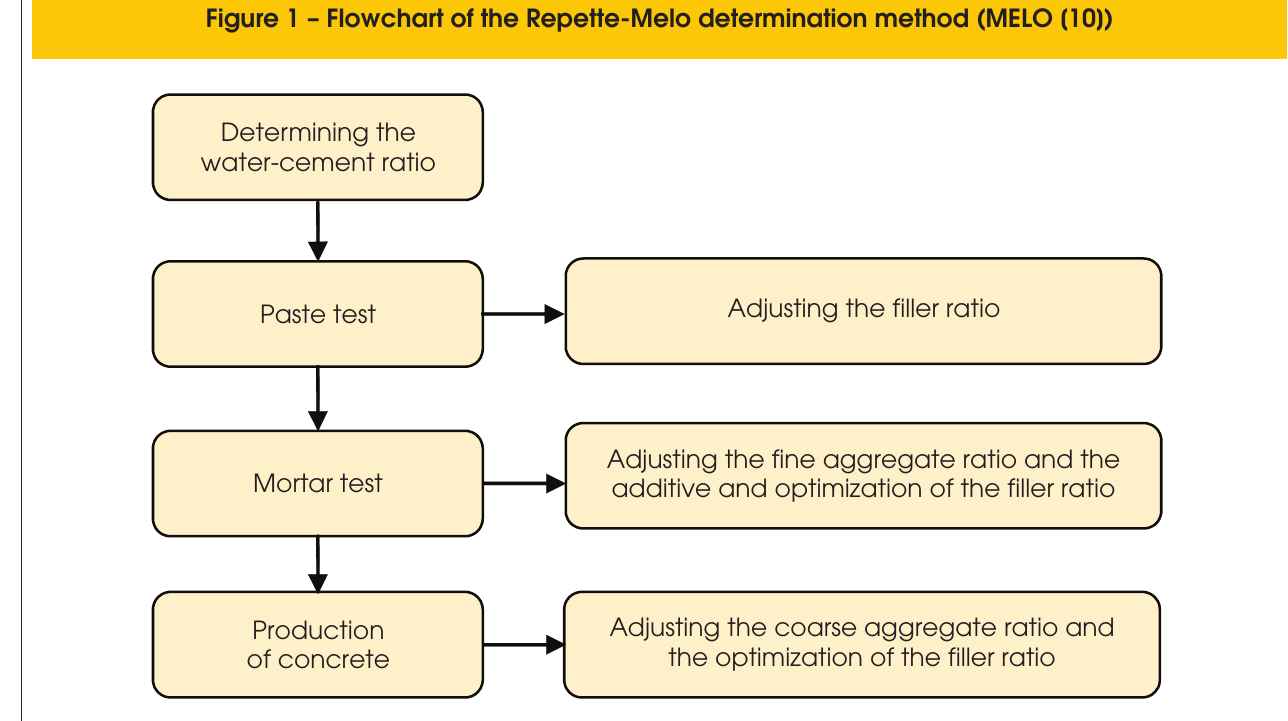
Figure 1 – Flowchart of the Repette-Melo determination method (MELO